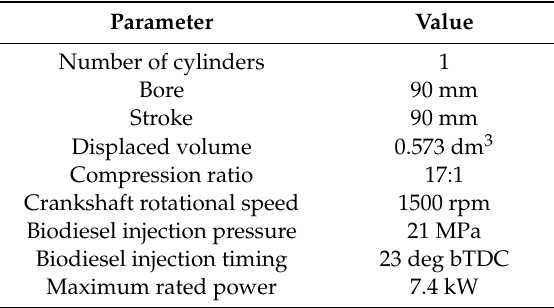
Figure 2. Diagram of the experimental setup. 1—engine, 2—diesel fuel injector, 3—gasoline fuel injector, 4—in cylinder pressure sensor, 5—intake air flowmeter, 6—air filter, 7—cooling fan, 8—exhaust gases temperature sensor, 9—PC with data acquisition system, 10—crank angle sensor. ( a ) experimental setup, ( b ) the test engine. Table 1. Main engine